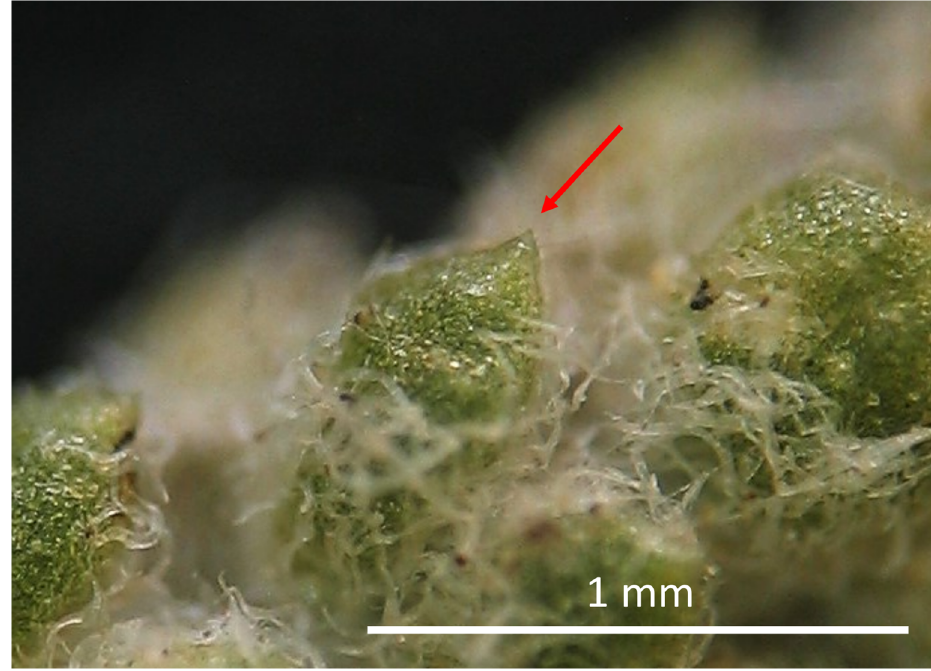
Figure 4. Small acute apex of leaf segments in Santolina villosa , indicated by the red arrow.